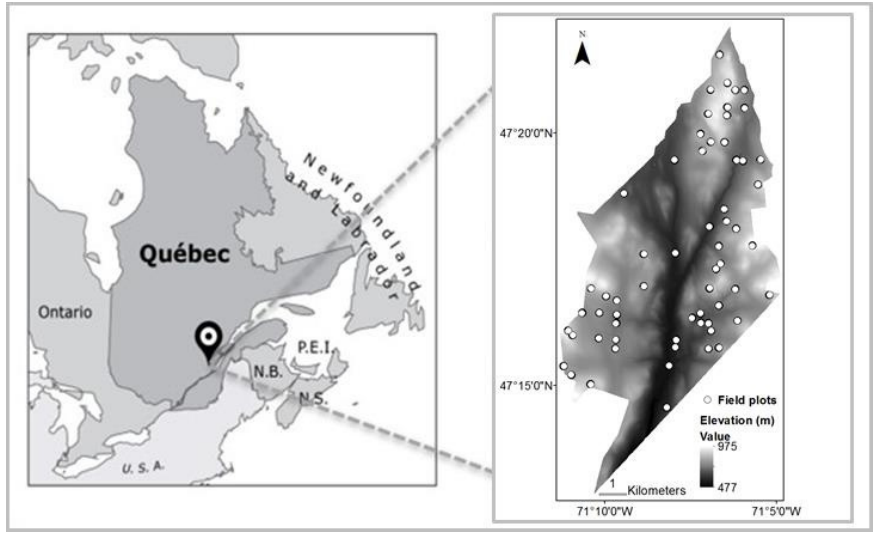
Figure 1. Location of the Montmorency Forest study site and the field plots over a lidar digital terrain model.